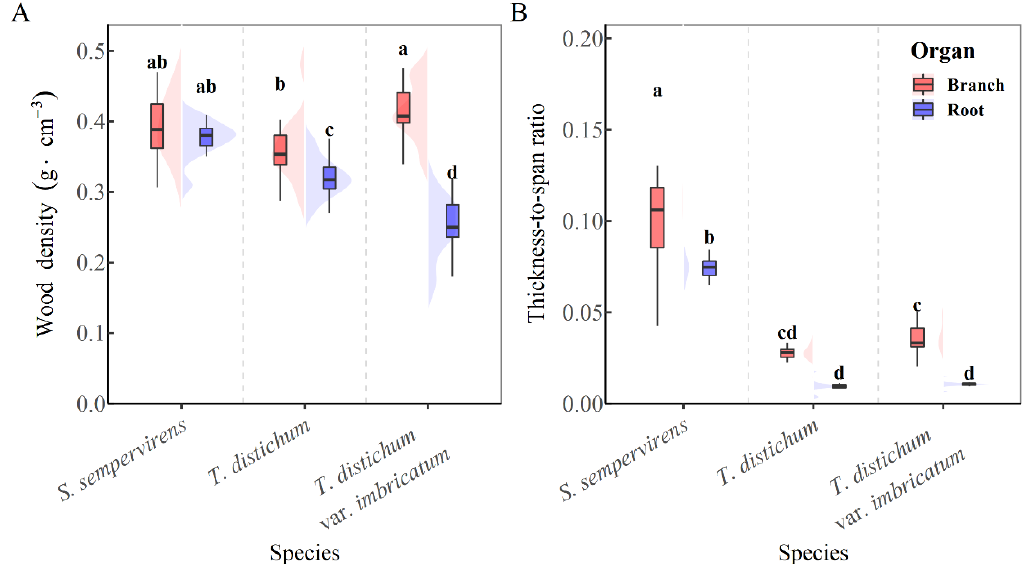
Figure 5. Wood density (WD, A ) and thickness-to-span ratio ( Ttob , B ) of the branches and roots in the three taxa. Different letters indicate a significant difference between means at p < 0.05 (multiple comparisons of treatments by means of a Tukey test).